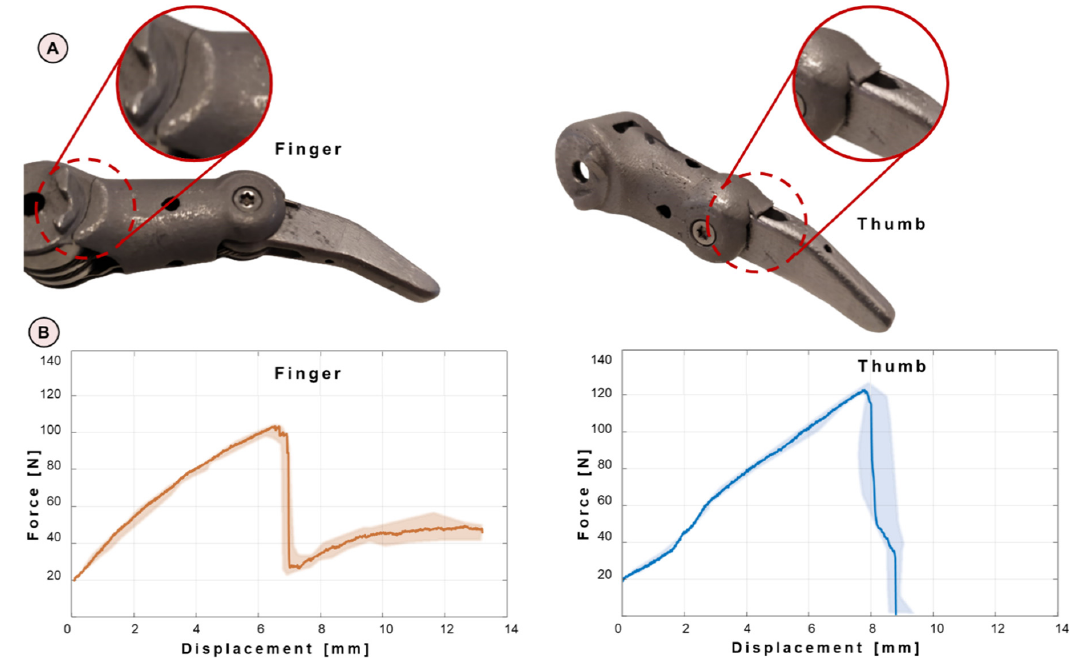
Figure 7. ( A ) Cracked regions from experimental tests on the finger ( left ) and thumb ( right ); ( B ) output in terms of force–applied displacement for both the fingers ( left ) and thumbs ( right ). The scatter of the experimental data is reported with pink (for the fingers, on the left) and light-blue bands (for the thumbs, on the right).